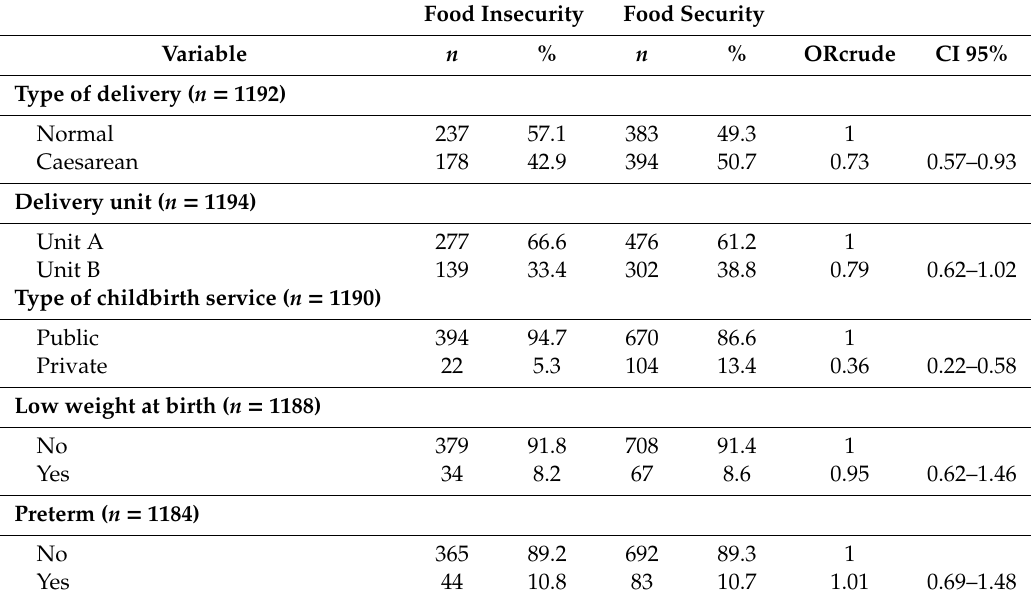
Table 4. Food insecurity during pregnancy according to delivery and weight of the newborn. Rio Branco, 2015.